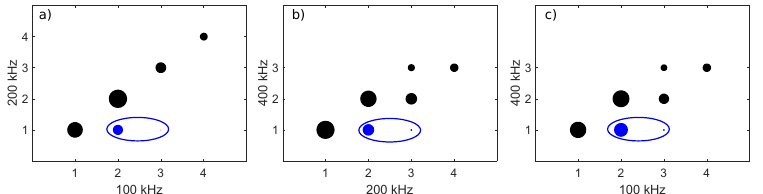
Figure 11. Matching matrix between the ACs of ( a ) 100 and 200, ( b ) 200 and 400, and ( c ) 100 and 400kHz for the Patricia